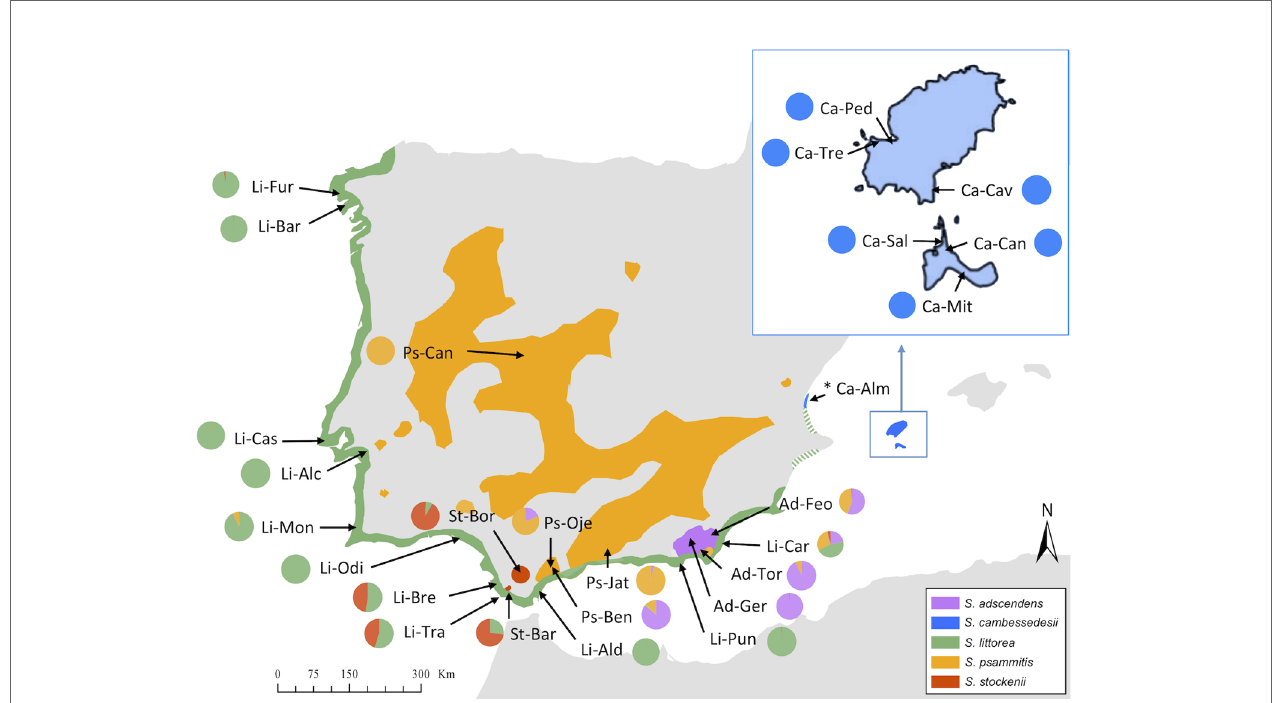
FIgURe 2 | Geographical distribution of studied populations of Silene section Psammophilae in the Iberian Peninsula and Balearic Islands and Discriminant Analysis of Principal Components (DAPC) results. Colored areas represent the distribution area of each species. The colored pie graphs represent the membership probability of each species according to the DAPC analysis on the complete plastid genome (cpDNA) when using species categories as priors. Species and population codes are shown in Table 1 .